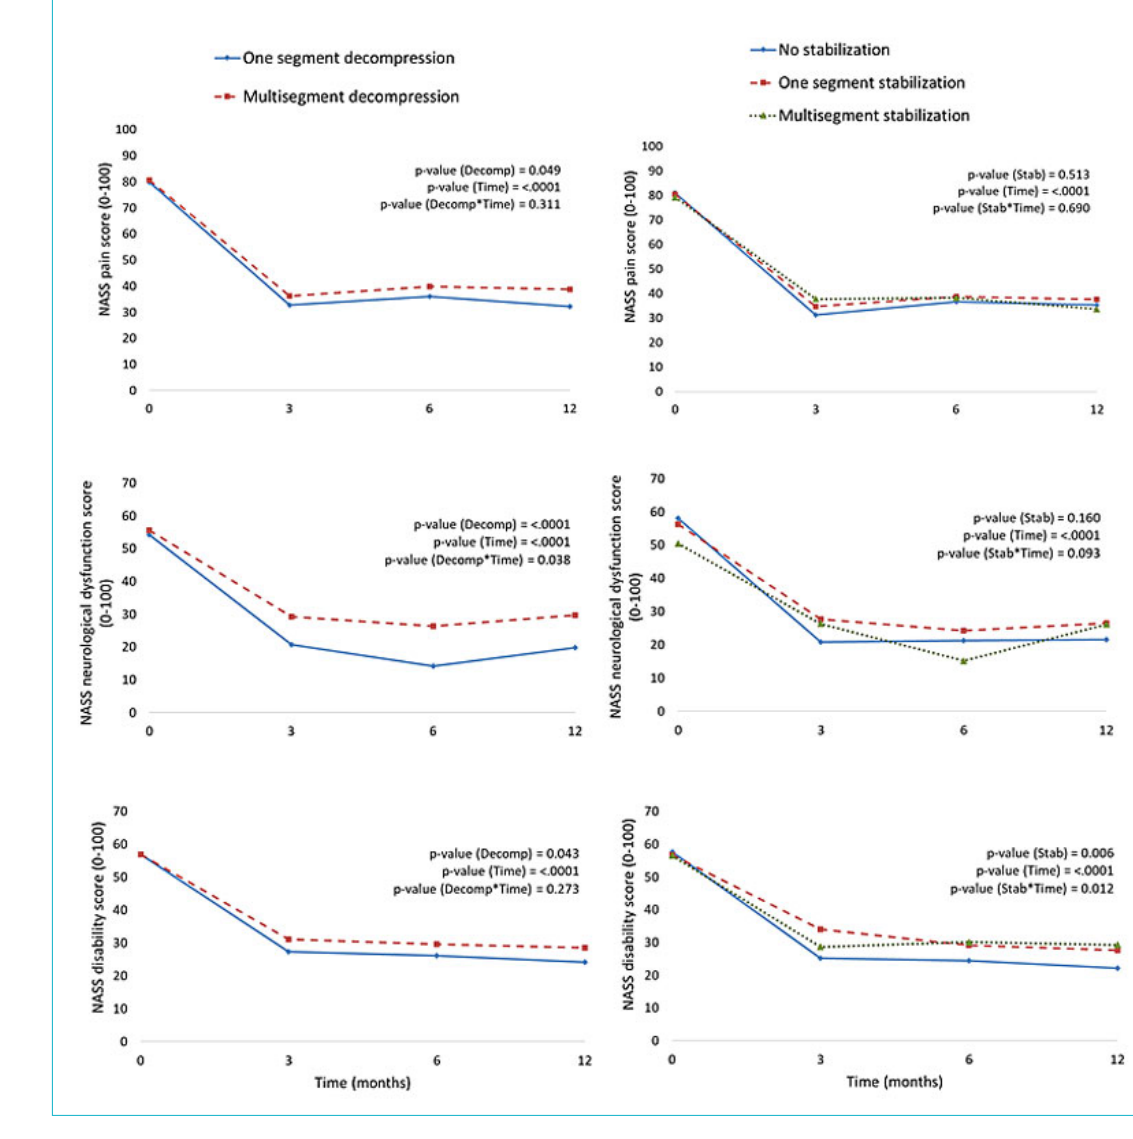
Figure 1: Timeline of recovery after spinal stenosis by decompression and stabilisation surgery types for the three outcomes North American Spine Society (NASS) pain scores, neurological dysfunction scores and disability scores over time. Data (n = 457) are means of absolute val- ues of NASS outcomes prior to the surgery (month “0”) and at 3- 6-, and 12-month follow-up after spinal stenosis surgery based on repeated- measures linear mixed effects ANCOVA